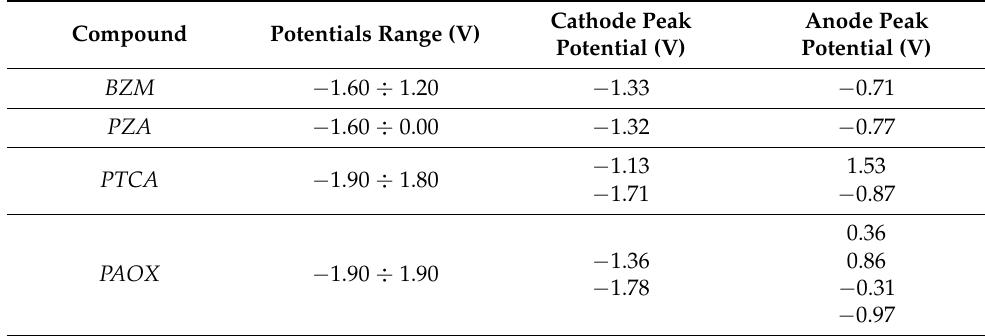
Table 1. The range of measuring potentials and the values of the potentials for the occurrence of the characteristic peak observed in CV’s for individual pyrazine derivative solution by unmodified